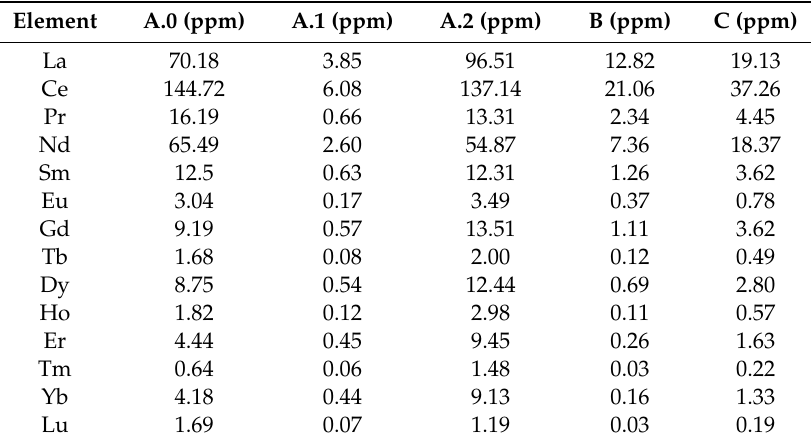
Table 7. Results of the analysis of five materials.